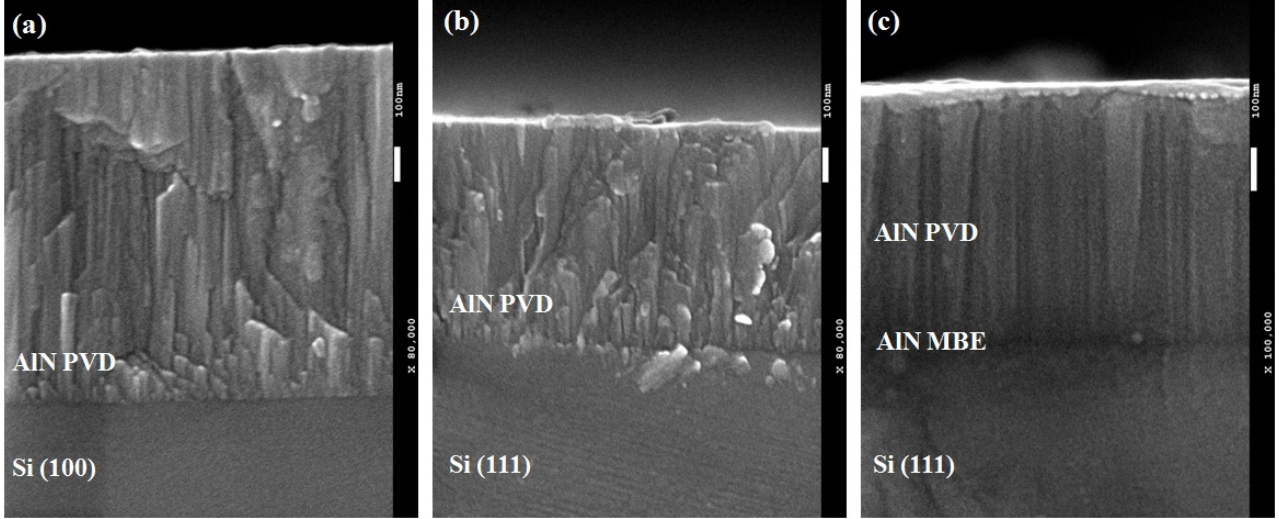
Figure 4. Cross section SEM image for ( a ) AlN/Si(100), ( b ) AlN/Si(111) and ( c ) AlN/AlN MBE/Si(111). Figure 5 represents the Raman spectra collected at room temperature from all samples. The